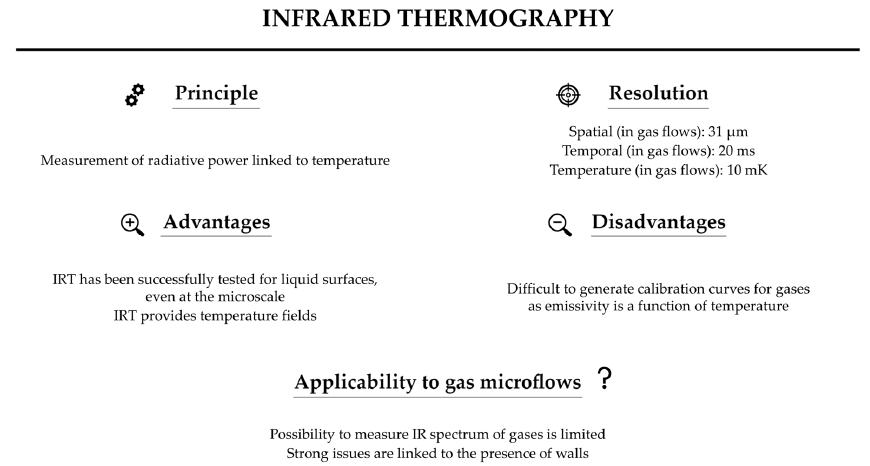
Figure 7. Summary of the main features of infrared thermography properties. Values of spatial and temporal resolutions are from [67], and value of temperature resolution is from [61].